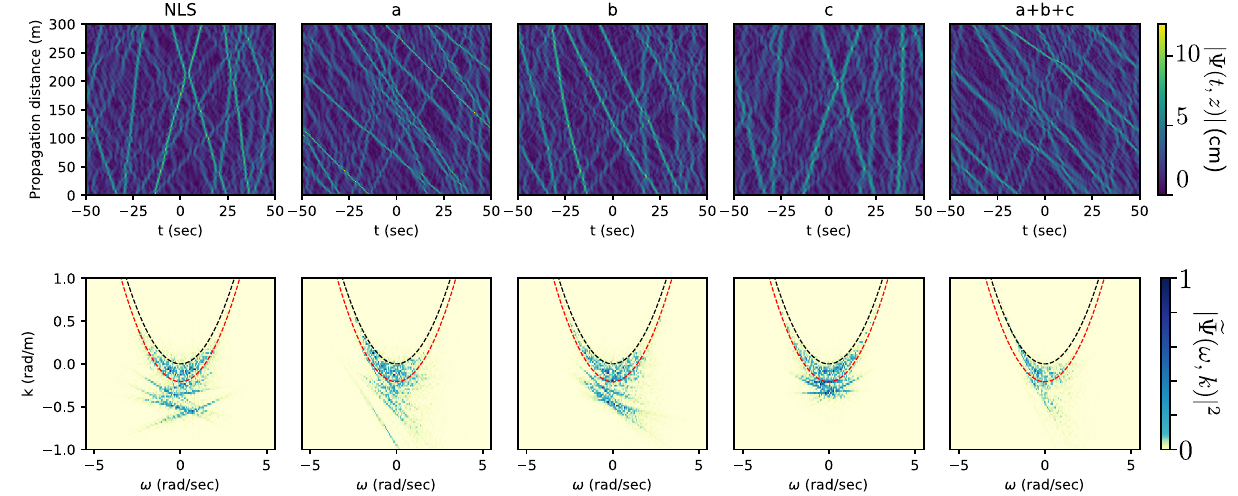
Figure 4. Numerical simulation of Dysthe model. Parameters correspond to Fig. 1a of the manuscript Ŵ = 0.65, ε = 0.14 (see “Methods”). Label ’NLS’ corresponds to simulations of 1DNLSE. Labels ’a’, ’b’, ’c’, and ’a indicate terms of Eq. (6) are added to the 1DNLSE